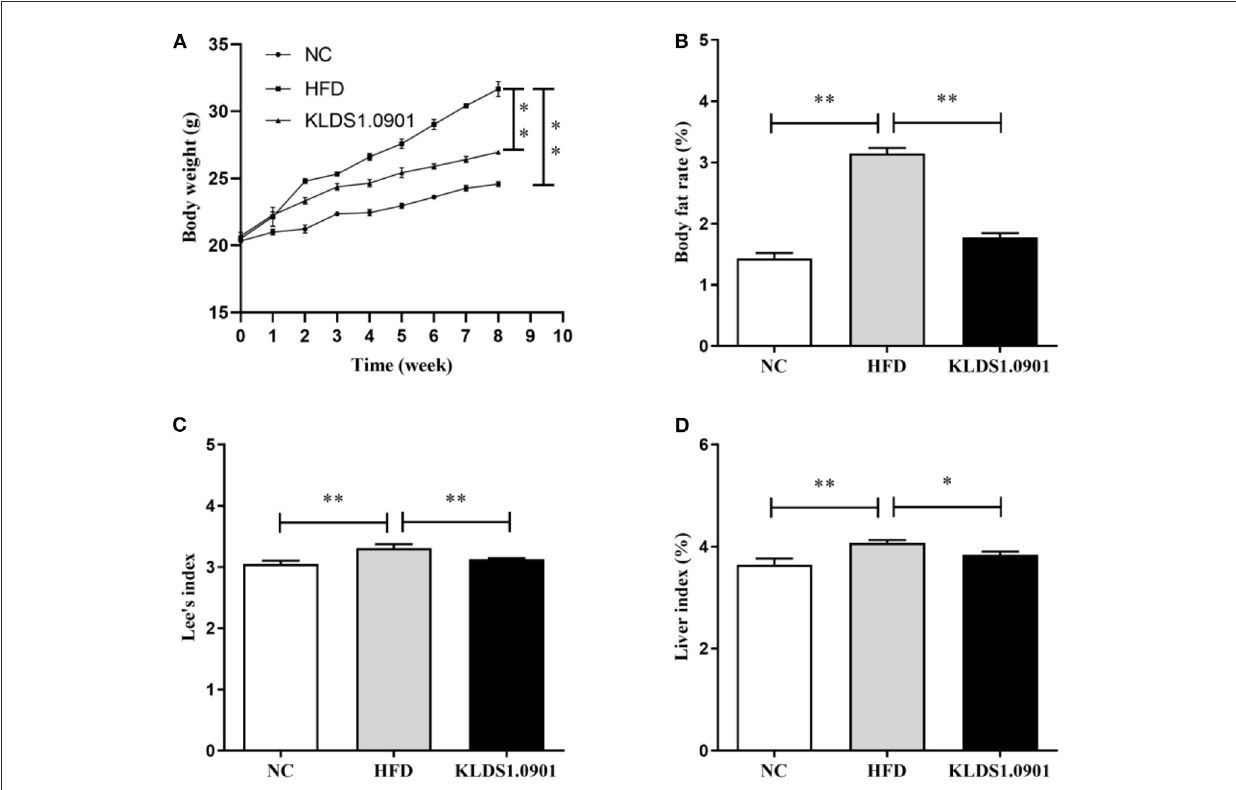
FIGURE1 Effect of L. acidophilus KLDS1.0901 administration on body weight (A) , body fat rate (B) , Lee’s index (C), and liver index (D) of HFD-fed mice. NC, normal control group; HFD, high-fat diet group; and KLDS1.0901, L. acidophilus KLDS1.0901 group. * p < 0.05 and ** p < 0.01 indicated that there was a significant difference when compared with the HFD